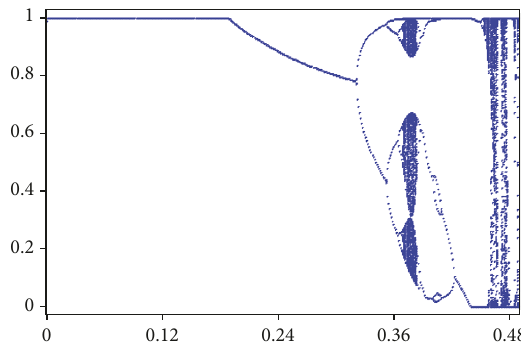
Figure 3: The bifurcation diagram of 𝑓 with respect to Δ ∈ (0,0.49] , for 𝑤 𝑥 = 1.5 , 𝑤 𝑦 = 1 , 𝑎(0) = 0.15